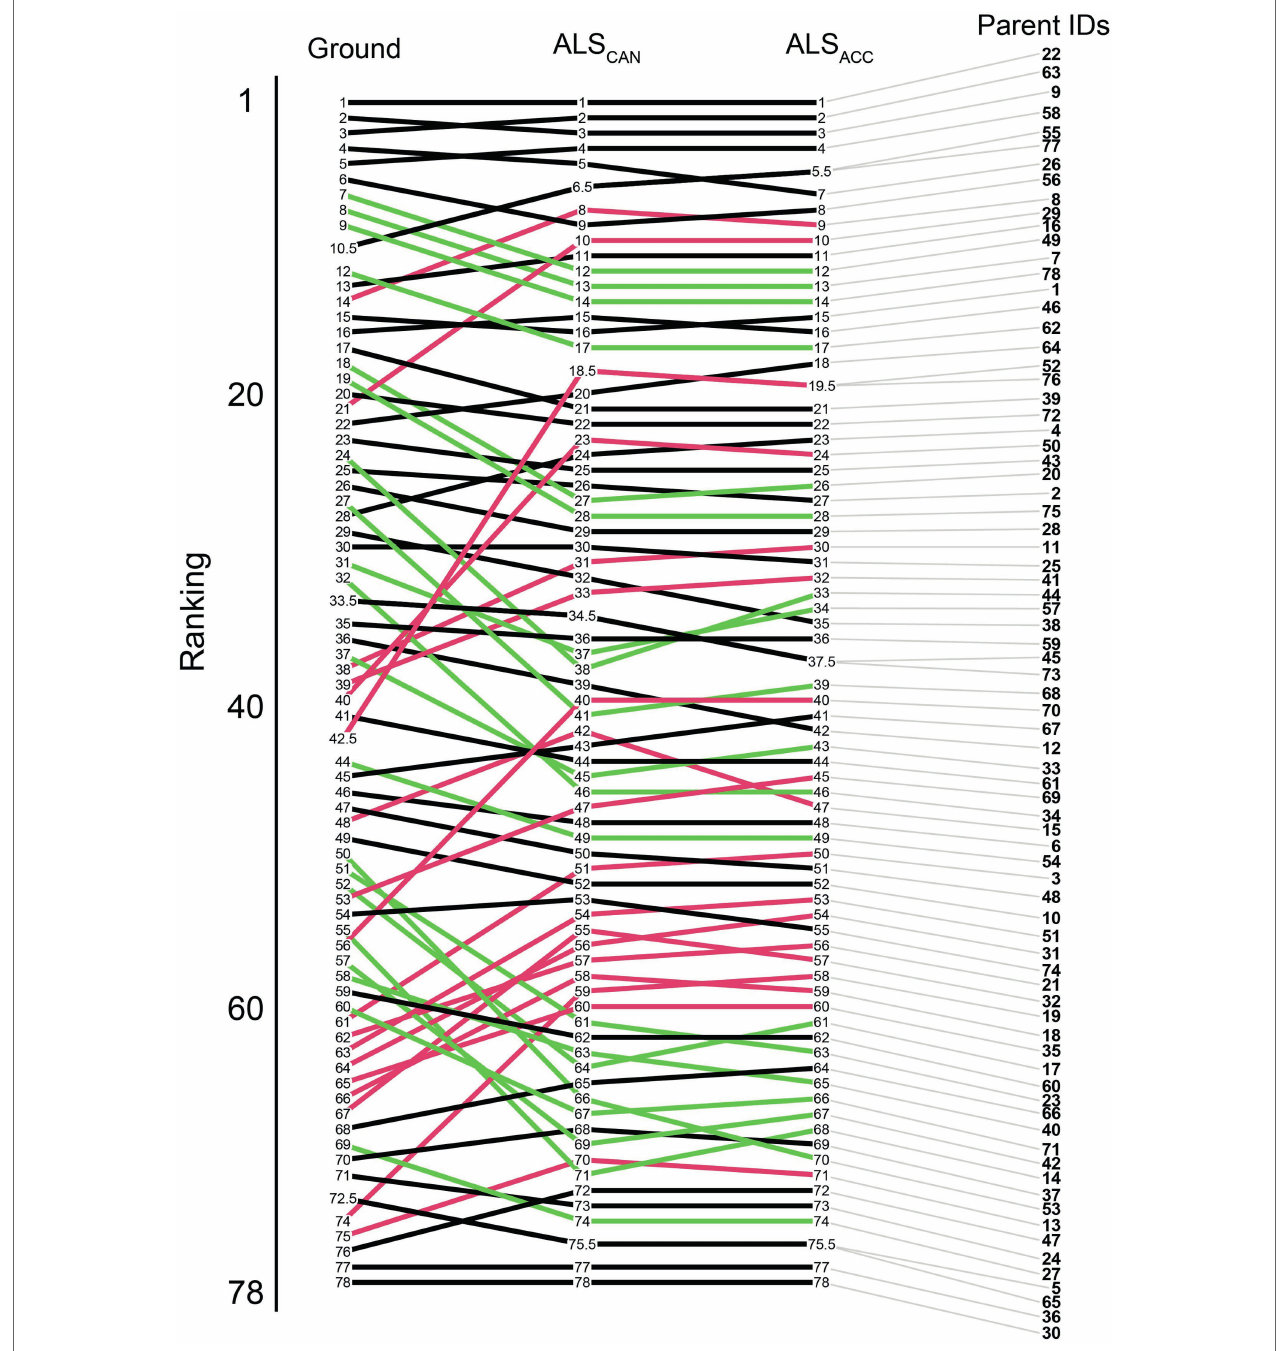
FIGURE 7 | EBV ranking changes for the parents in the trial from the ground-based model (left) to the candidate ALS model (ALS CAN , center), and the most accurate ALS-based model (ALS ACC , right). Green lines indicate a ranking improvement of 5 or greater, red lines indicate ranking decreases of 5 or greater between the ground-based and candidate models. Black lines indicate changes of less than five ranking